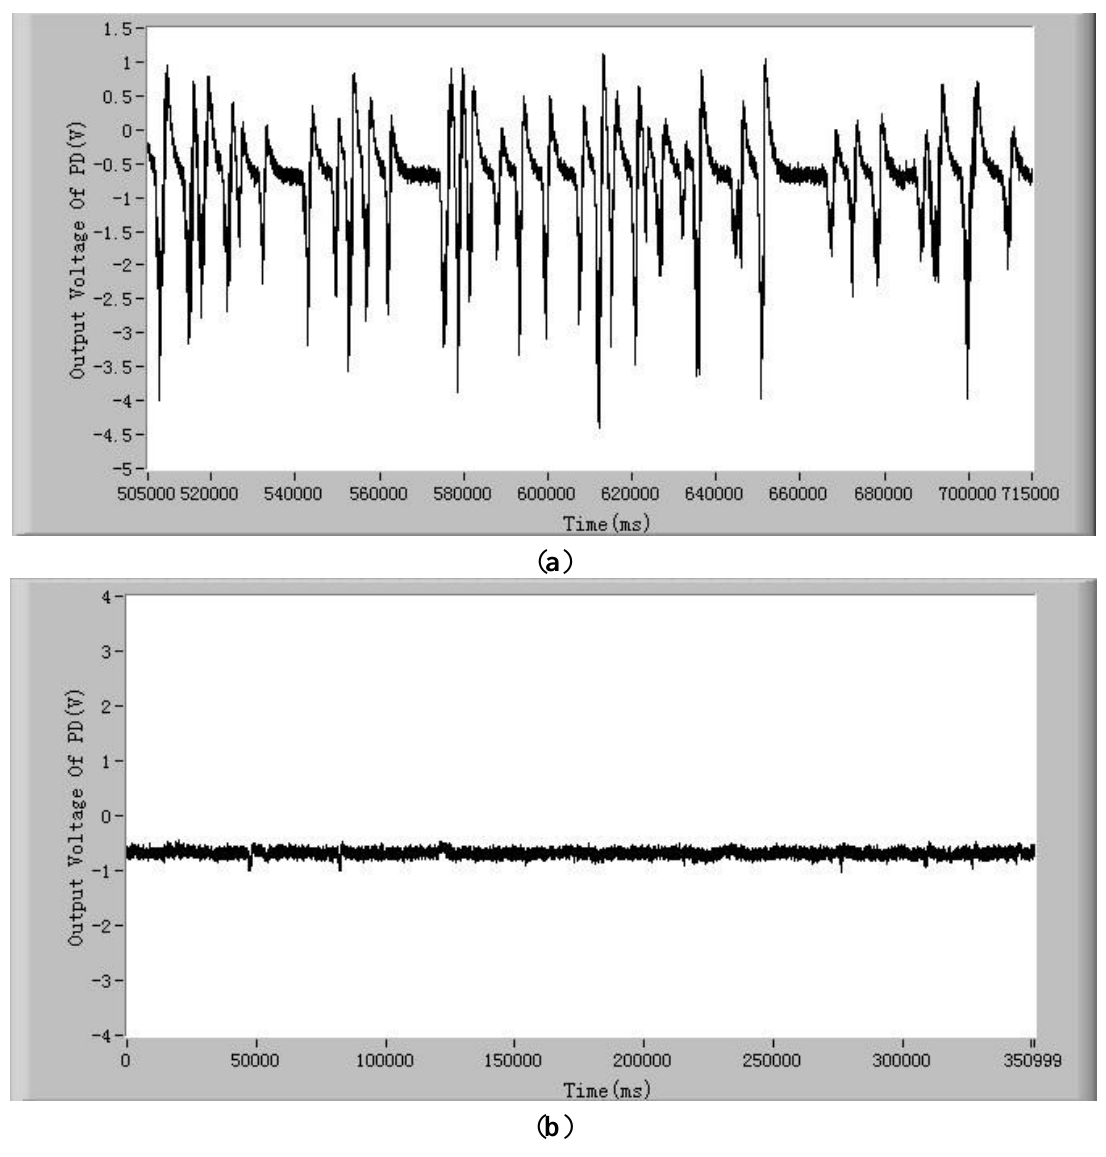
Figure 2. Typical chlorophyll fluorescence signals of Karenia mikimotoi Hansen ( a ) individual living cells ( b ) dead cells ( c ) an enlarged view of a living cell signal. And ( d ) average chlorophyll fluorescence intensity of living and dead cells after being treated in darkness. The excitation light power is 2 mW and temperature is 21